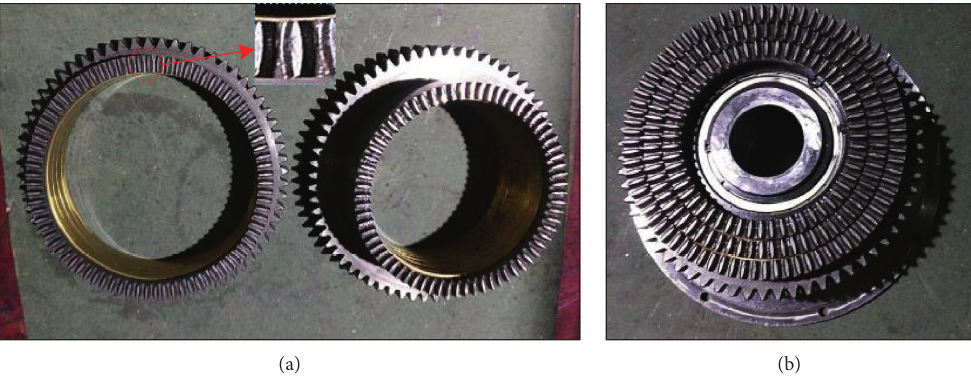
Figure 2: Physical prototype of multistage face gears. (a) Single-stage face gear. (b) Assembled multistage face